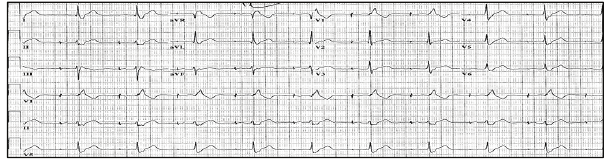
Figure 3: Patient’s 12-lead electrocardiogram after the pacemaker insertion. The tracing revealed electronic atrial paced rhythm, left axis deviation, and right bundle branch